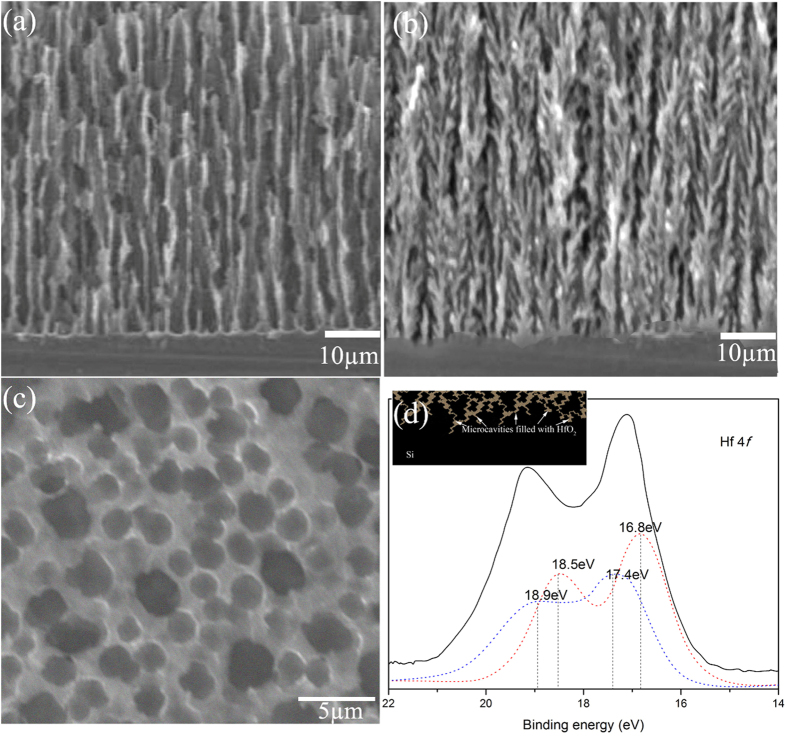
Cross-sectional SEM image of (a) cross section of the porous silicon without HfO2 filling and (b) with HfO2 filling. (c) is the frontside SEM image of the porous silicon layer. (d) is the Hf 4f core level spectra for HfO2-filling samples. Silicide subpeaks can be observed for samples, which implies the introduction of Si within HfO2 dielectric. From deconvolution, it consists of Hf-Si bond (Hf 4f 5/2 :18.9 eV; Hf 4f 7/2 :17.4 eV) besides Hf-O component (Hf4f 5/2 :18.5 eV; Hf 4f 7/2 :16.8 eV). The diagram of microcavities filled with HfO2 in porous Si is shown in the inset.